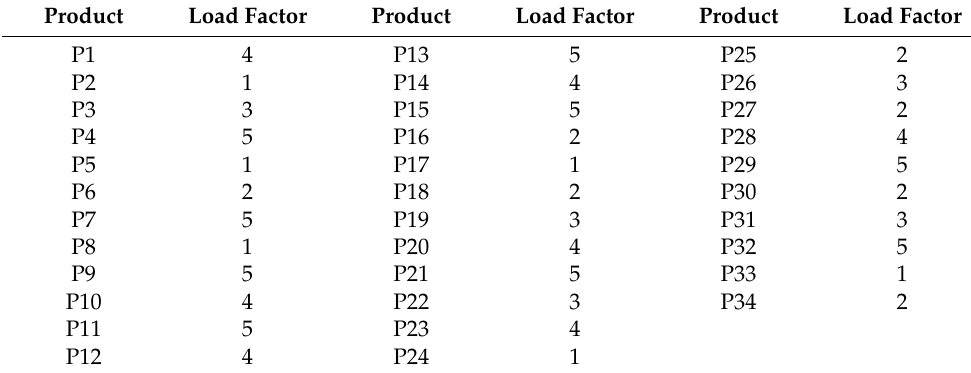
Table 4. Load Factor for Case 4.